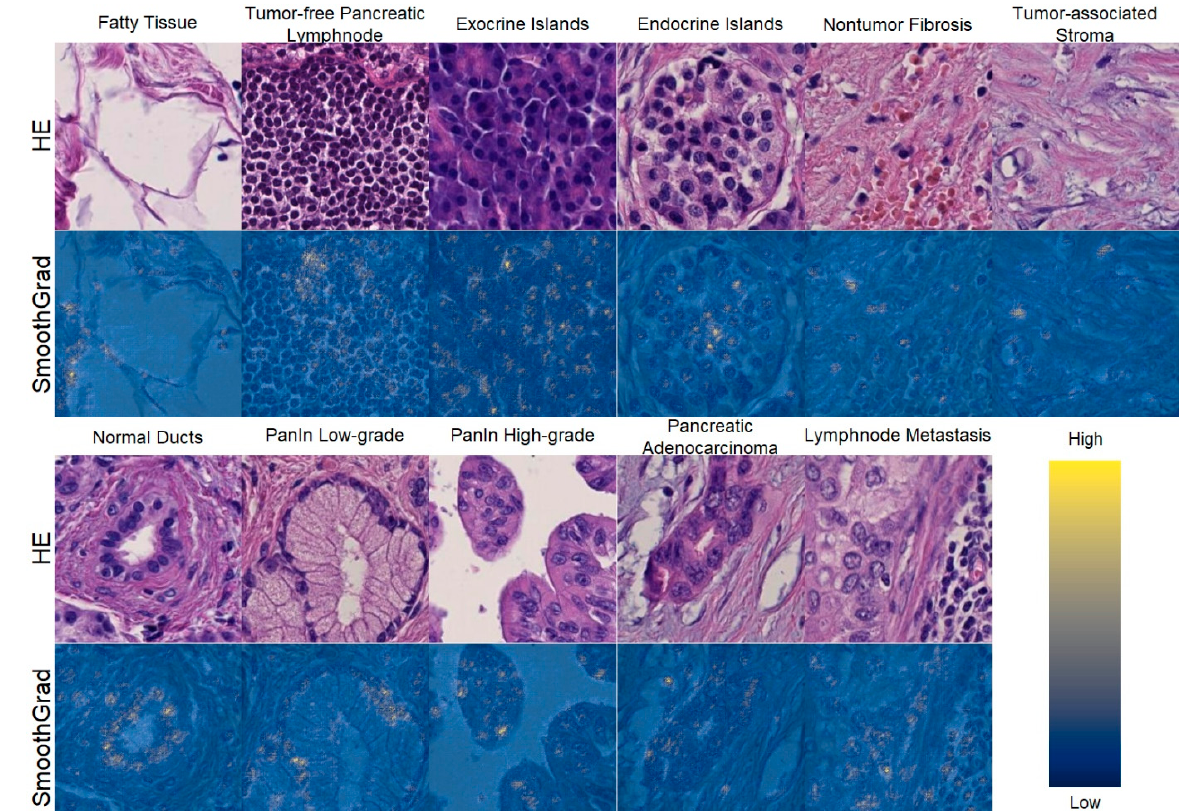
Figure 4. SmoothGrad heatmaps of exemplary image patches that have been classified correctly and highlight cellular structures. For each class, the upper plot shows the original image patch, while the lower plot shows the patch overlaid with the SmothGrad heatmap in respect to the class of the image patch. High SmoothGrad activity scores can be seen in areas overlaid with cells or nuclei. This confirms that the algorithm classified the image patches based on cellular morphology. Scale: each image 100 × 100 μ m (219 × 219 px).